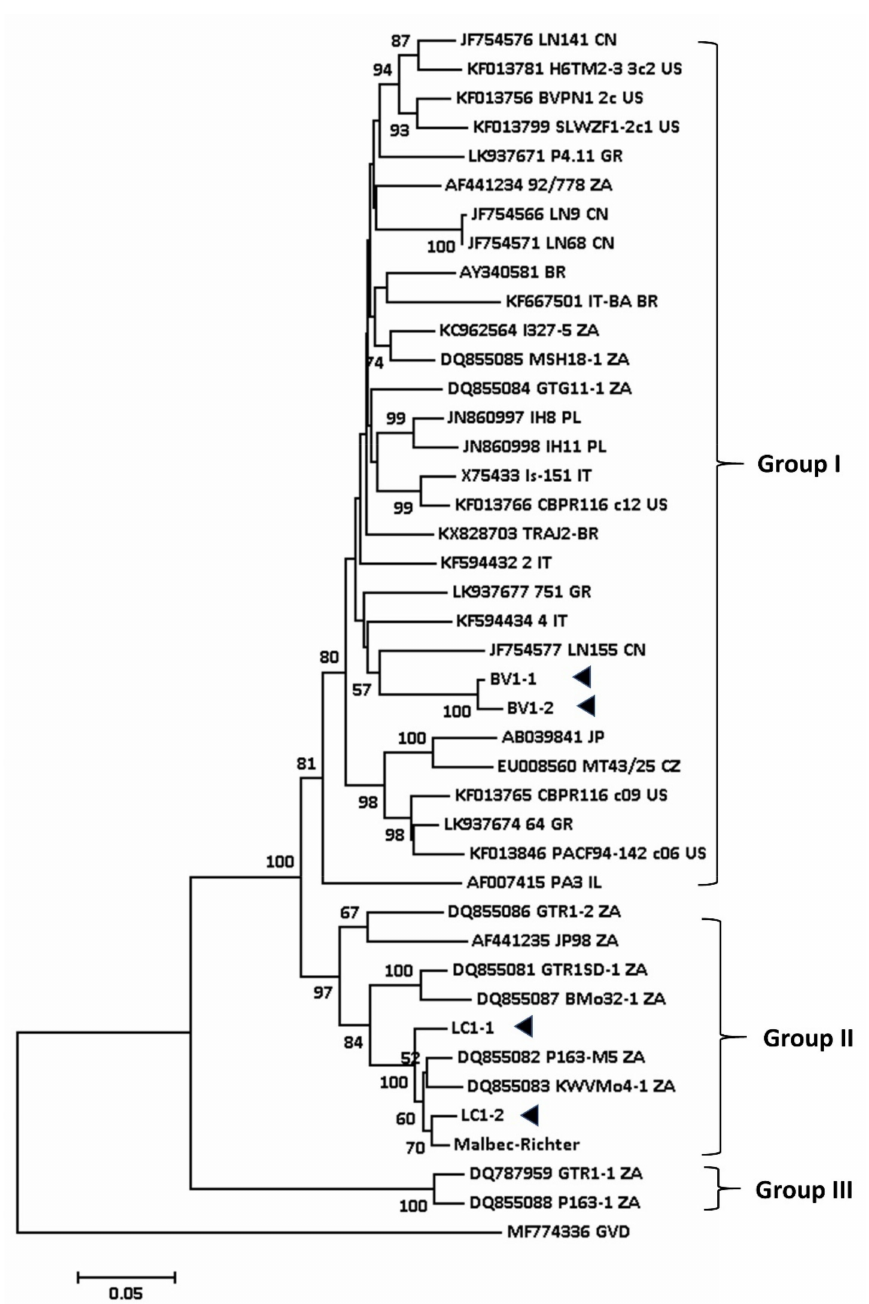
Figure 3. Phylogenetic tree constructed from the alignment of full-length nucleotide sequence of the coat protein of selected isolates of GVA detected in the grapevine using neighbour-joining method (Mega 7) with 1000 bootstrap replications. Bootstrap values less than 50% are not shown. Arrowheads denote the GVA isolates from Australia studied in this work. GVD (MF774336) presents outgroup of this